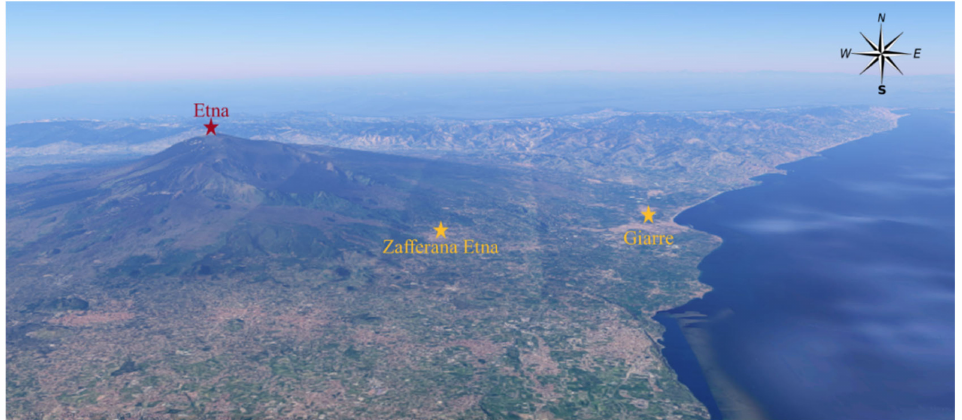
Figure3. MapshowingthepositionofEtnavolcanoalongwithGiarreandZa ff eranaEtnea. The distance between Etna and Giarre is about 30 km, while that between the volcano and Za ff erana Etnea is about 18 km as the crow